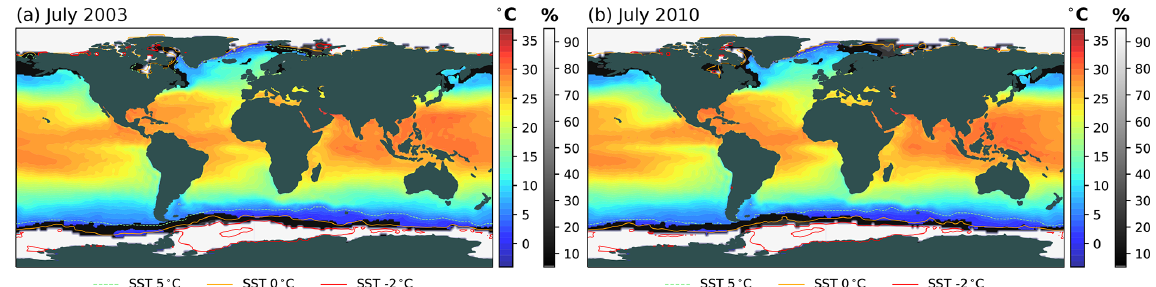
Figure 4. Counterfactual SST [ ◦ C] in shaded colours and factual SIC [%] in greyscale for (a) July 2003 and (b) July 2010. The SST 5 ◦ C (dashed green), 0 ◦ C (orange), and − 2 ◦ C (red) contours are marked for